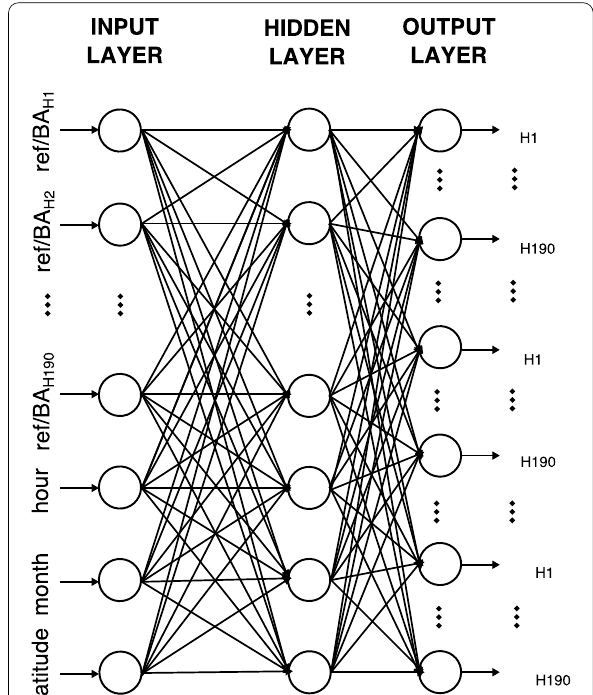
Fig. 1 Example of the MLP structure used in this study. The input consists of refractivity (ref) or bending angle (BA) profiles for 190 altitude levels (H 1 –H 190 ) together with latitude, hour and month of RO event. Temperature ( T ), pressure ( P ) and water vapor pressure ( Vp ) profiles for the corresponding altitude levels form the